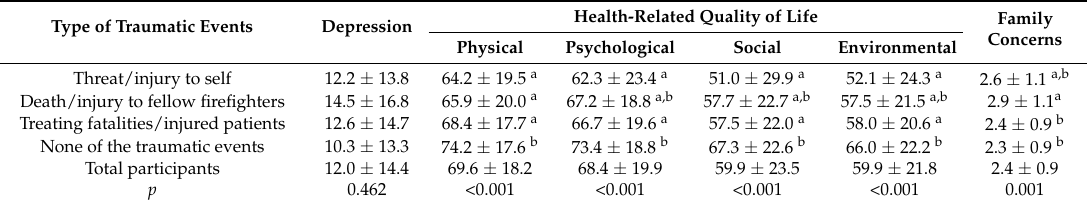
Table 3. Depression, health-related quality of life, and family concerns by work-related traumatic